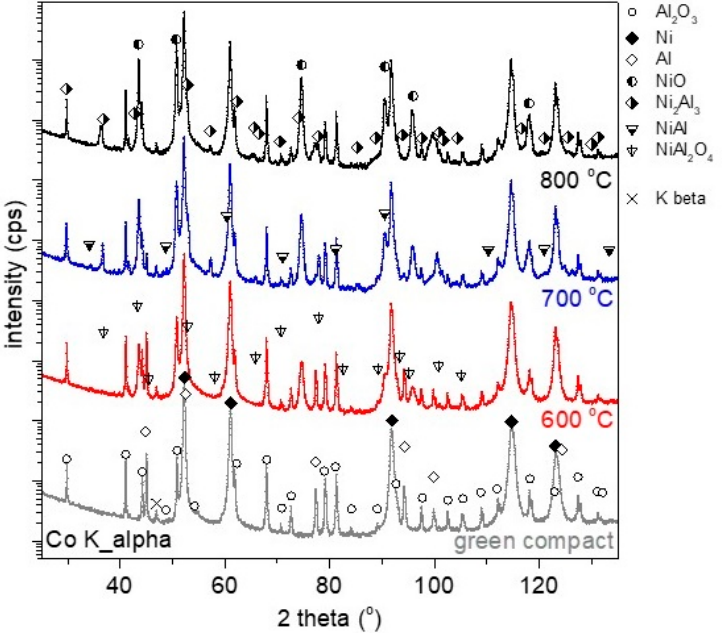
Figure 7. X-ray diffraction of the green compact (dark gray color), oxidized compact to 600 ◦ C + 2 h hold (red color), oxidized compact to 700 ◦ C + 2 h hold (blue color), and oxidized compact to 800 ◦ C + 2 h hold (black color), data shifted vertically for clarity.